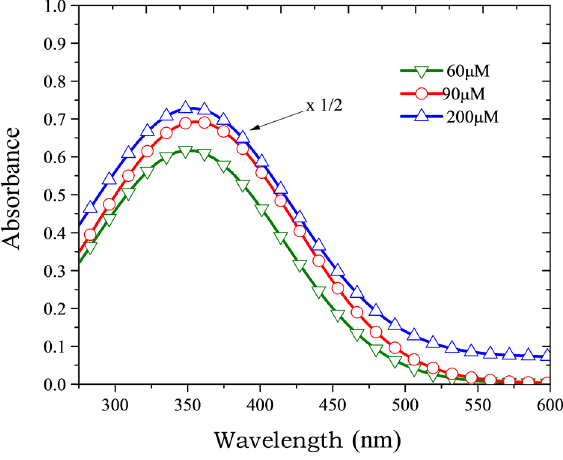
Figure 2. Absorption spectra of PFO-co-pX in tetrahydrofuran (THF) for different concentrations.